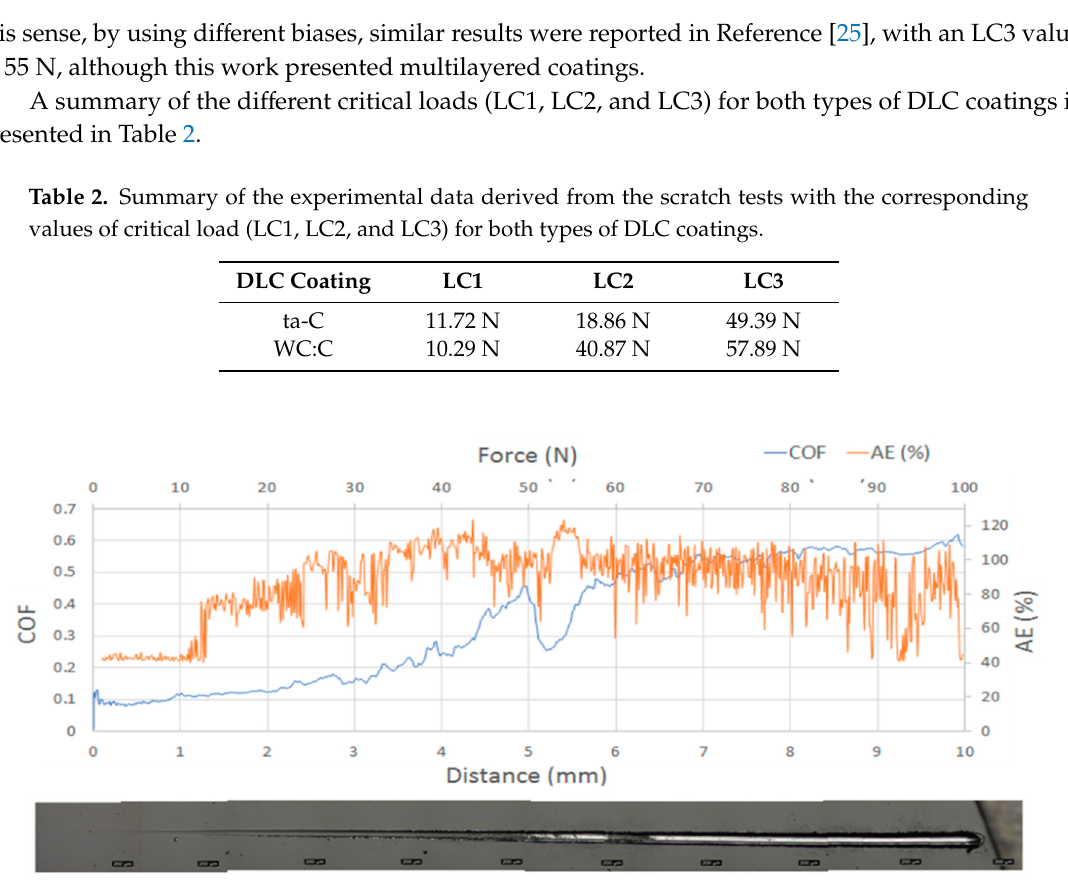
Figure 7. Nanoscratch test for ta-C coating. Evolution of the coefficient of friction (COF, blue plot) and the acoustic emission (AE, orange plot) vs. the indenter displacement, and optical micrograph of the scratch tracks.